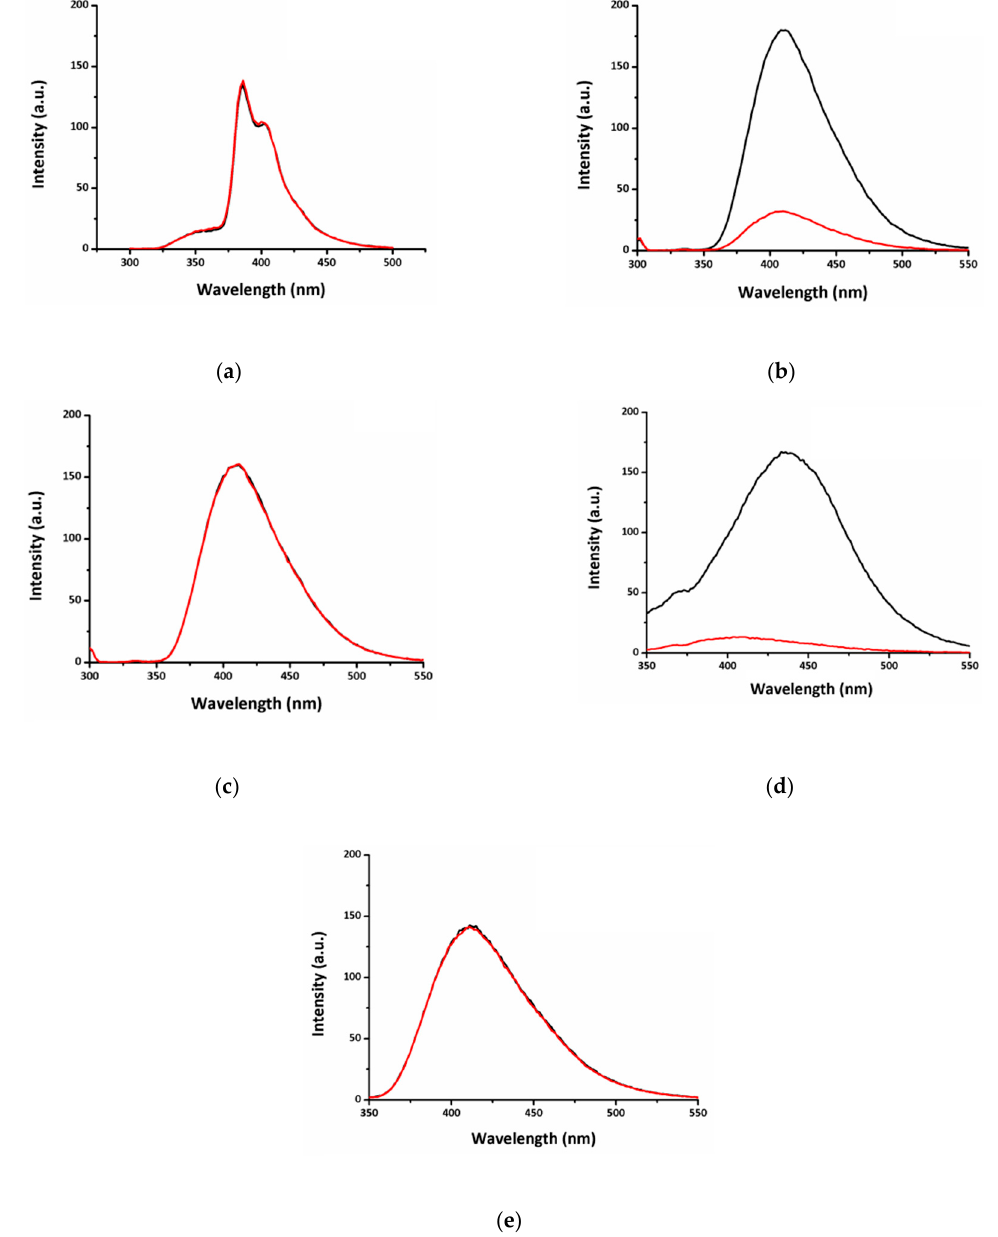
Figure 2. Fluorescence intensities of 2a – e (30 μ M) in DMSO/HEPES buffer ( v / v , 1/9) in the absence (black lines) and presence (red lines) of one equivalent of CuCl 2 at their corresponding excitation maxima (see Table 1) ( a ) 2a ; ( b ) 2b ; ( c ) 2c ; ( d ) 2d ; ( e ) 2e .